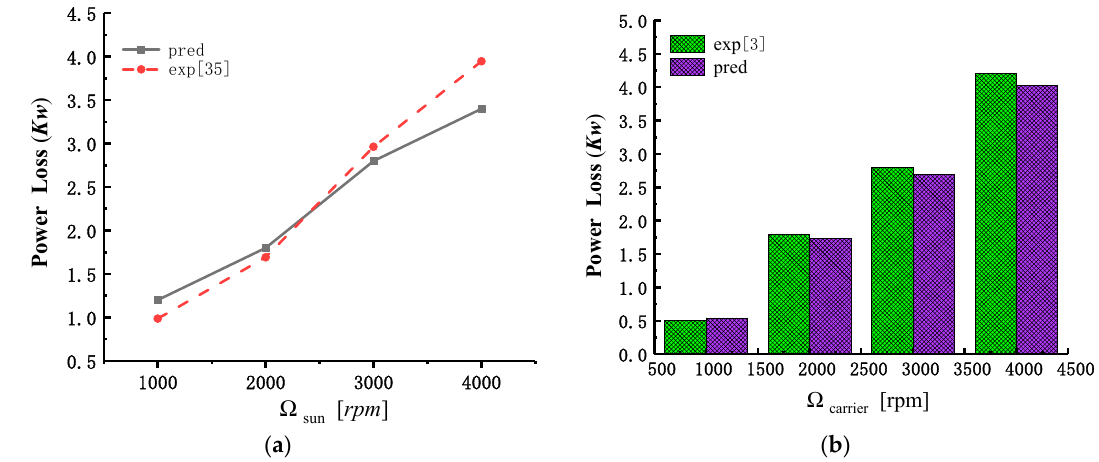
Figure 19. Power loss comparison with literature experimental results. ( a ) Tooth surface friction power loss; ( b ) total power loss.